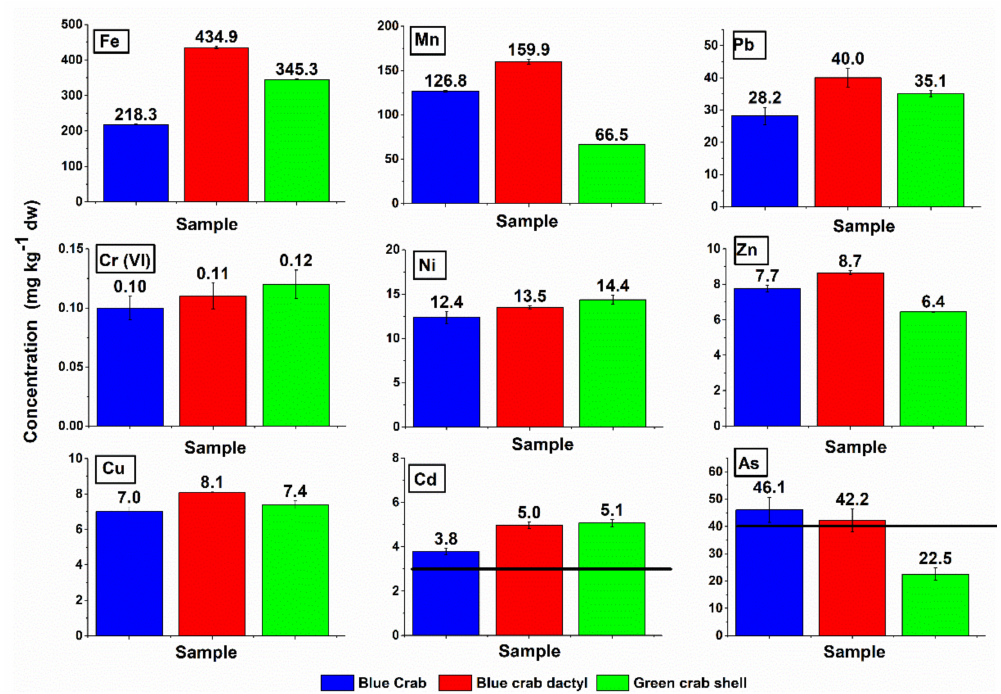
Figure 3. Heavy metal contents (mg kg − 1 dw) determined in the shells of the blue crab ( Callinectes sapidus ) and the green crab ( Carcinus aestuarii ) of eastern Adriatic Sea origin, near an industrial and agricultural zone (Neretva river delta, Croatia). Error bars represent R.S.D. ( n = 3). Black horizontal line: prescribed maximum permissible level of metal for inorganic macronutrient fertilizers [12].